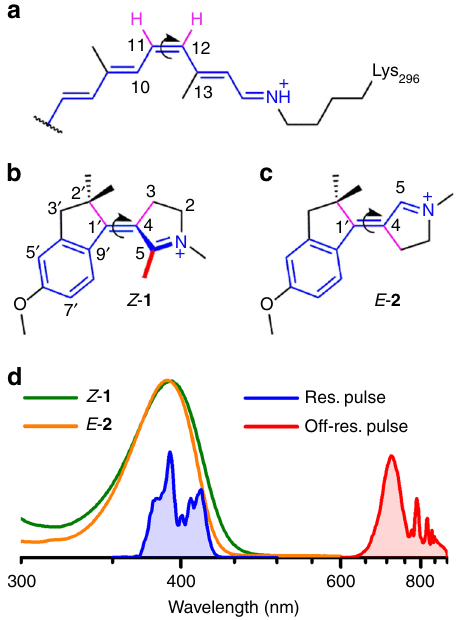
Fig. 1 Structure and absorption spectra of the NAIP compounds. a The 11- cis PSBR chromophore of Rh (the curly arrow indicate the 11- cis to all- trans photoisomerization reaction) inspired the chemical design of ( b ) MeO- NAIP 1 and ( c ) “ C5-demethylated ” dMe-MeO-NAIP 2 . Their most stable S 0 isomers are Z - 1 and E - 2 . The elementary CH 3 to H substitution in Z - 1 at position C5 alters the Z/E equilibrium in favor of a more stable E form. The three compounds have a similar π -electron system (blue molecular backbones) with an S 1 state characterized by a bond length alternation and partial reduction of the protonated Schiff base through charge transfer along the carbon backbone. They also have an analogous photoreaction coordinate, which involves the torsion around the central C = C double bond (curved arrows) as well as out-of-plane motions of the purple bonds. d Steady-state absorption spectra of Z - 1 (in green) and E - 2 (in orange) together with the femtosecond laser pulse spectra used for resonant (blue) and off-resonance (red) vibrational coherence